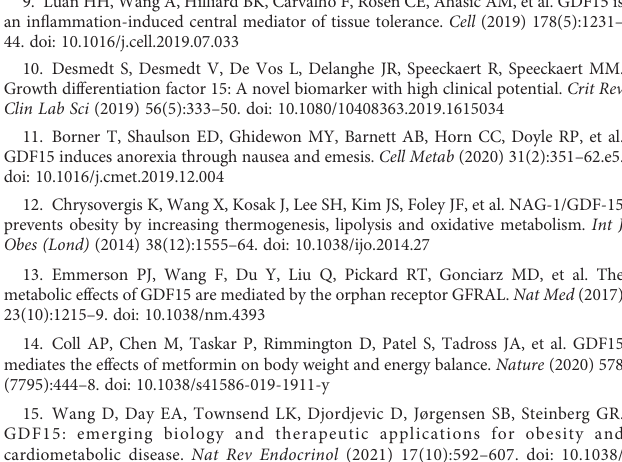
SUPPLEMENTARY FIGURE 1 Begg ’ s funnel plot for the assessment of potential publication bias in the samples ( A : mRNA; B : protein). SUPPLEMENTARY FIGURE 2 Sensitivity test of GDF-15 expression between GDM patients and non-GDM pregnant women ( A : mRNA; B : protein). SUPPLEMENTARY FIGURE 3 Difference of GDF-15 mRNA expression between GDM patients and non-GDM pregnant women (excluding preeclampsia or other diseases that may in fl uence GDF-15 expression). SUPPLEMENTARY FIGURE 4 Difference of GDF-15 protein expression between GDM patients and non-GDM pregnant women (excluding preeclampsia or other diseases that may in fl uence GDF-15